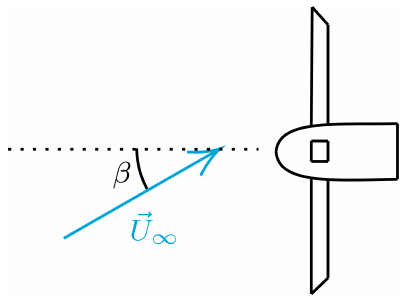
Figure 11. Top view of turbine with definition of side slip angle β . Dotted line represents the rotor